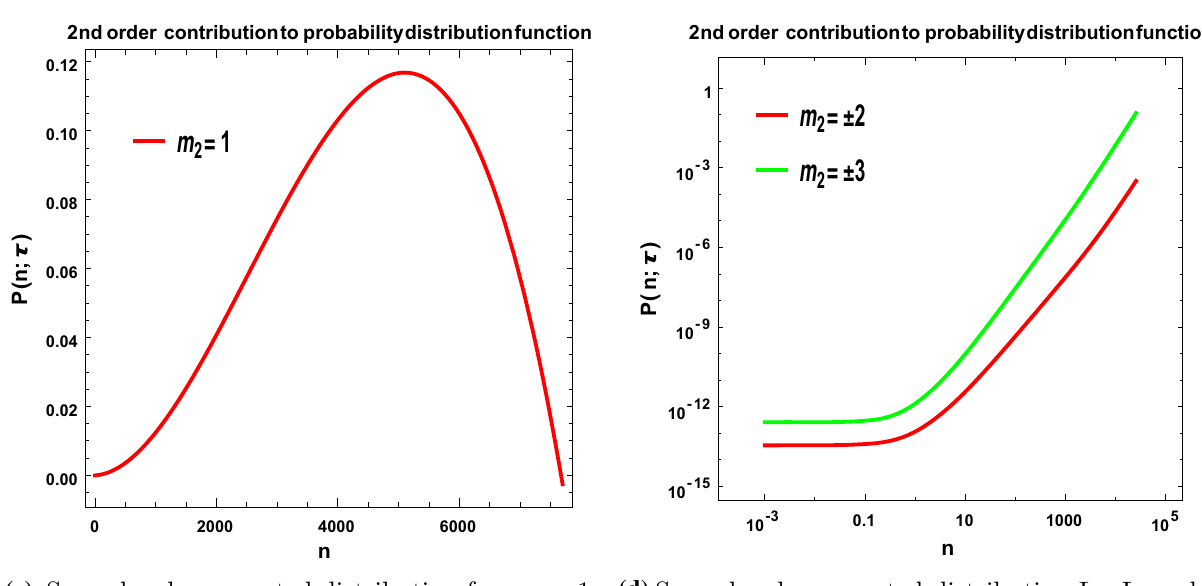
Fig. 39 Evolution of probability distribution function obtained from the second order corrected Fokker–Planck equation with the occupation number n for different value of m 2 . Here we use the initial conditions as mentioned in Eq.